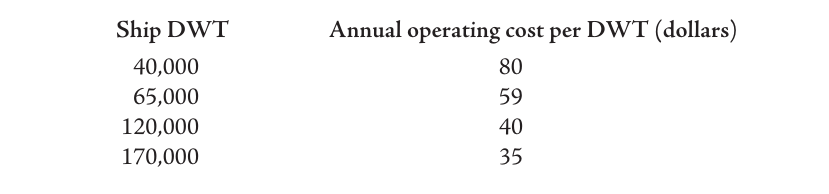
Table 1– Operating Cost Per DWT (dollars per year) Table 2 – Relative Economies of Scale by Ship Size and Voyage